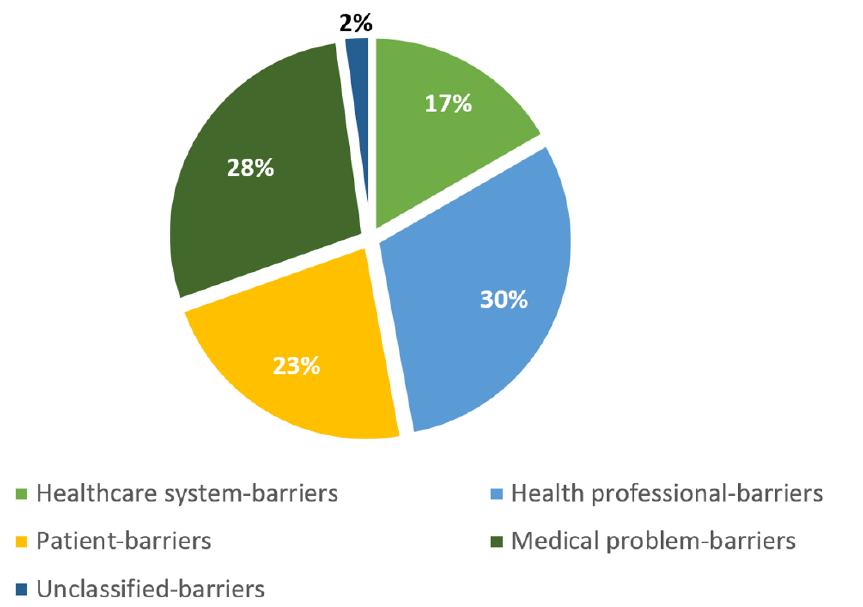
Figure 2. Levels of barriers to cardiac rehabilitation (CR) enrollment. Distribution of barriers to cardiac rehabilitation (CR) enrollment of patients with heart failure with reduced ejection fraction (HFrEF) by different levels: healthcare system-level (items 1, 2, 3, 5, 19, 20), health professional-level (item 16), patient-level (items 4, 6, 7, 8, 9, 10, 11, 12, 13, 15, 17, 18, 21, 22.3), medical problem-level (item 14), and unclassified-level (items 22.1, 22.2). CR: cardiac rehabilitation; HFrEF: heart failure with reduced ejection fraction.